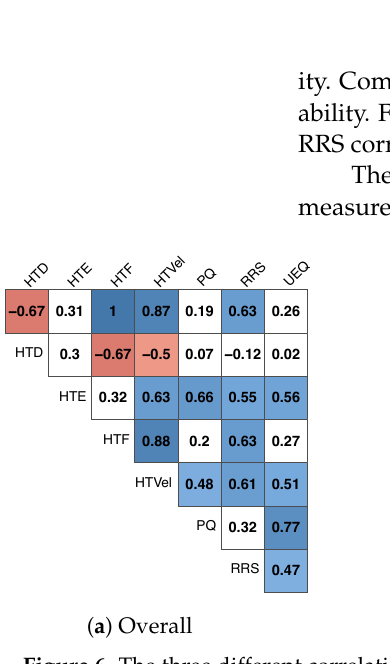
Figure 6. The three different correlation matrices depict the Pearson’s linear correlation coefficients between the head turn characteristics, the RRS and the subjectively perceived presence and user experience of all ( a ), inexperienced (InEXP) ( b ) and experienced (EXP) ( c ) athletes. Significant correlations are marked by color a